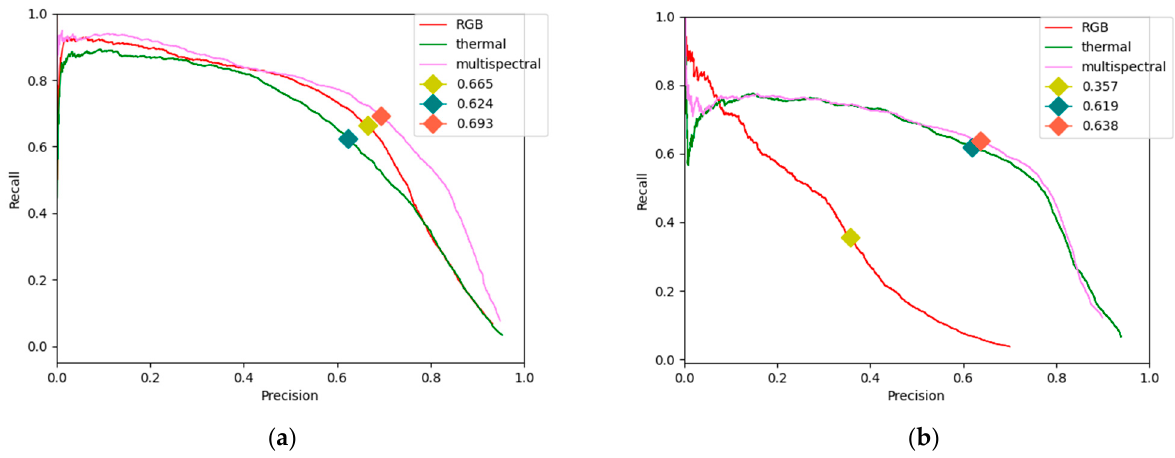
Figure 5. Detection accuracy comparison based on the different image sources between ( a ) daytime and ( b ) nighttime.